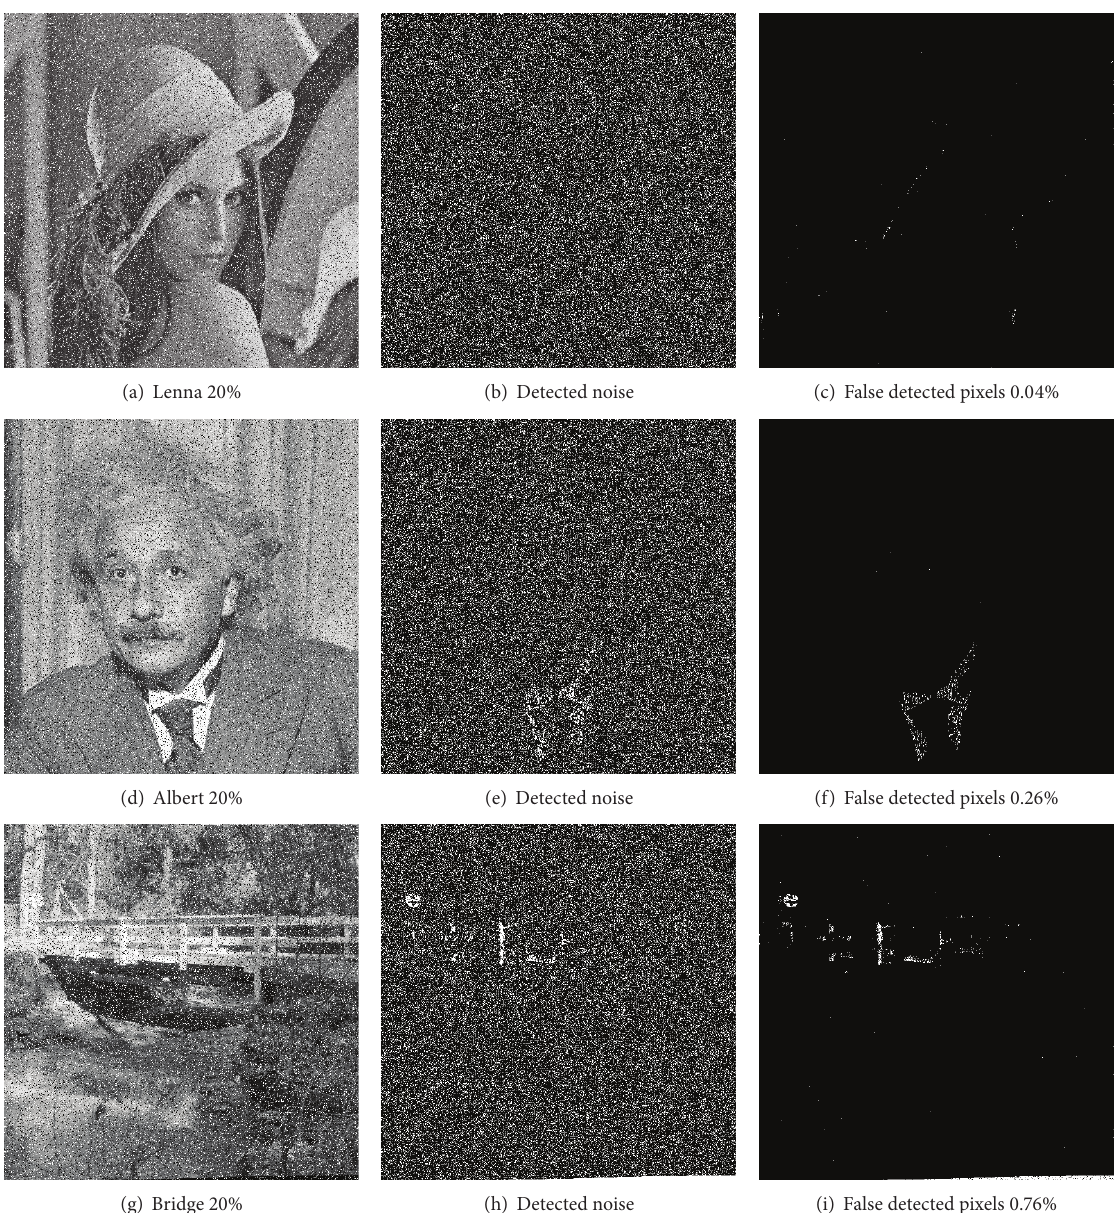
Figure 2: Examples of noise detection for images Lenna and